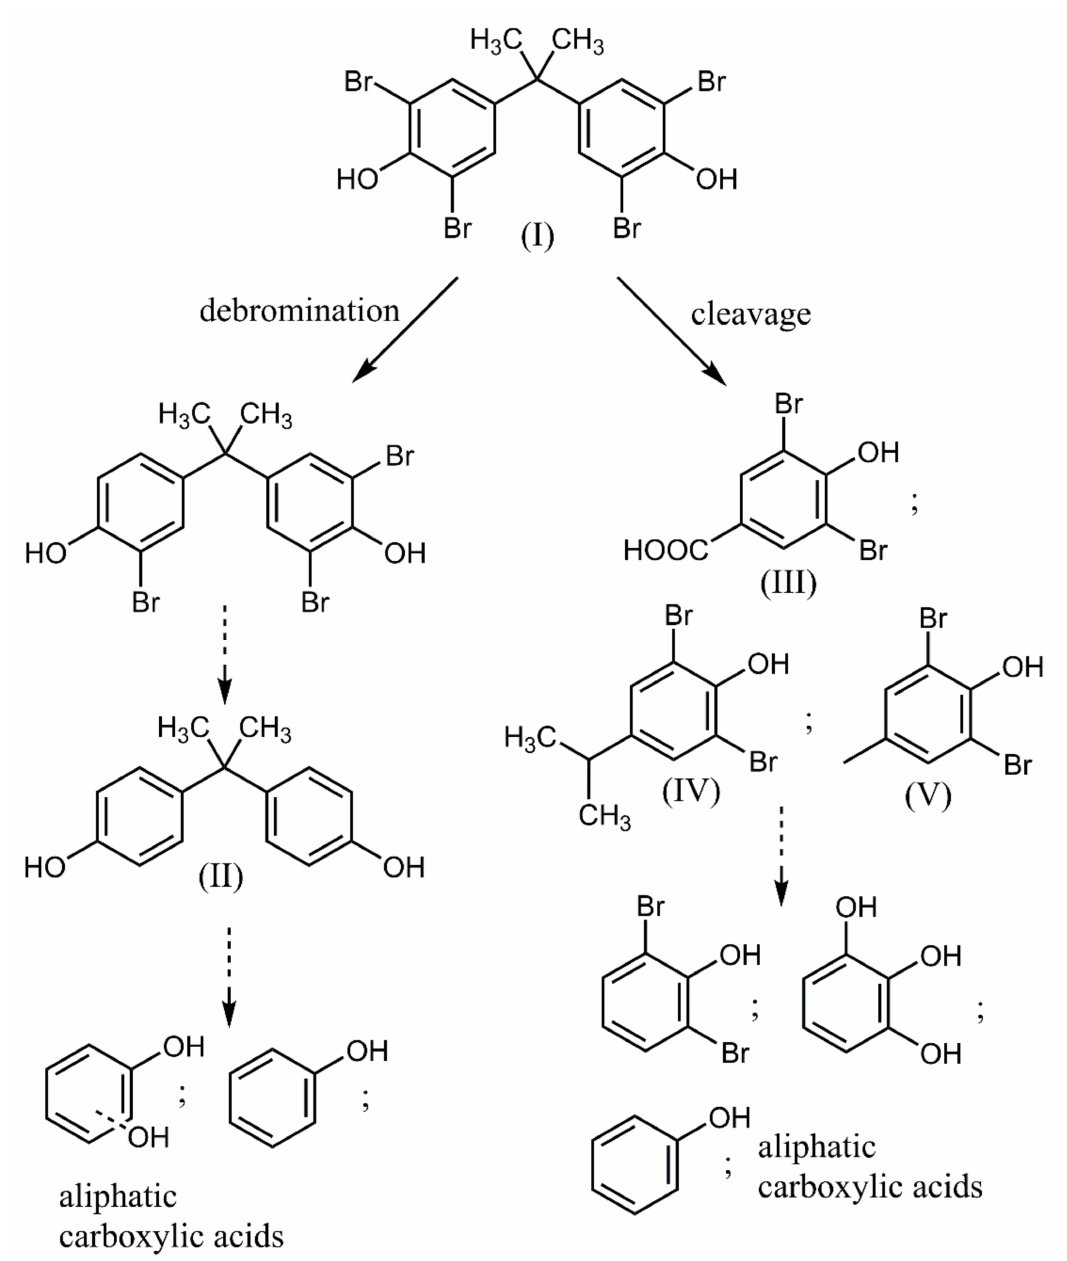
Figure 6. Schematic presentation of TBBPA degradation organic products. Acute toxic values were expressed as EC 50 values (concentration for 50% of maximal effect, mg/L) with 95% confidence intervals and were calculated by the Regtox spreadsheet. The obtained values of EC 50 24 h are summarized in Table 2 and are presented visually in Figure